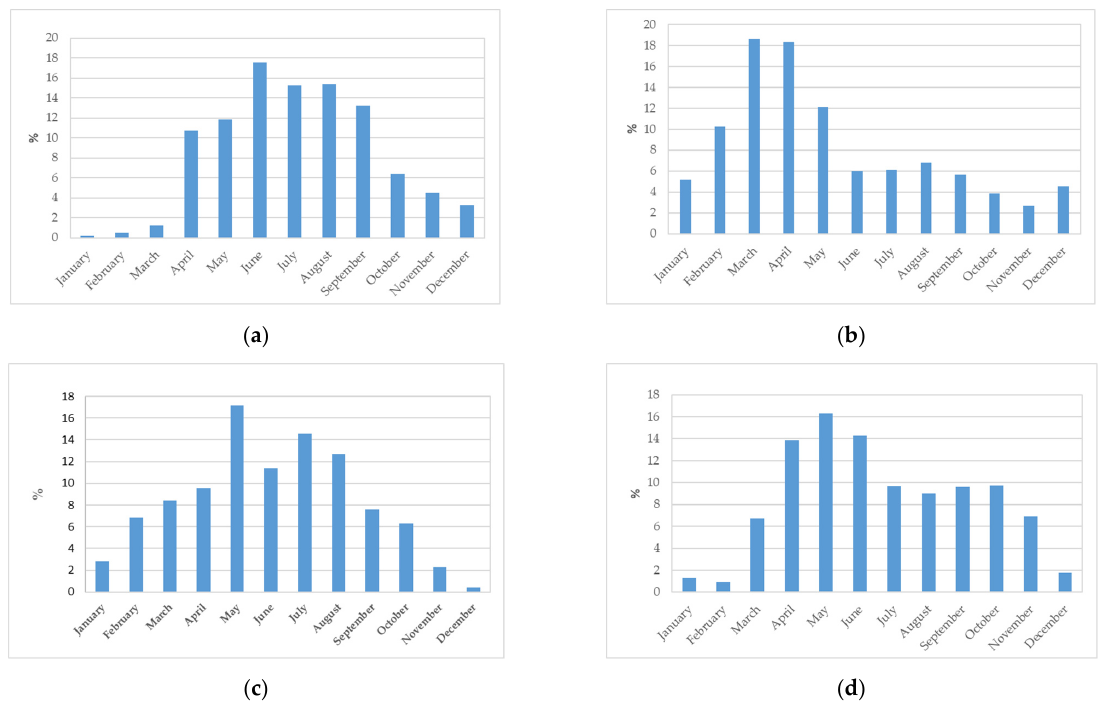
Figure 12. Distribution of IWC in some of the irrigated zones in Jordan. An example from year 2017 for ( a ) NJV; ( b ) Irbid-Ramtha; ( c ) Mafraq; ( d ) Quwayrah-Disi.